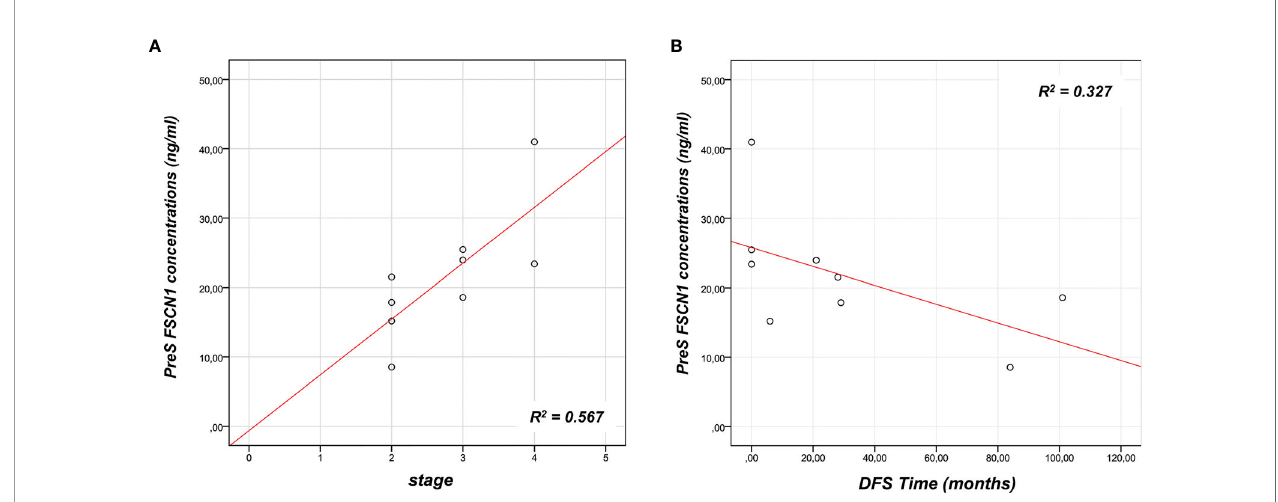
FIGURE 2 | Association between FSCN1 levels and ACC parameters. A statistically signi fi cant positive linear correlation was found between pre-surgery FSCN1 concentrations (PreS) and stage - r=0.784, R 2 = 0.567, p=0.012, n=9 (A) , and a statistically signi fi cant negative linear correlation with the disease-free survival time -